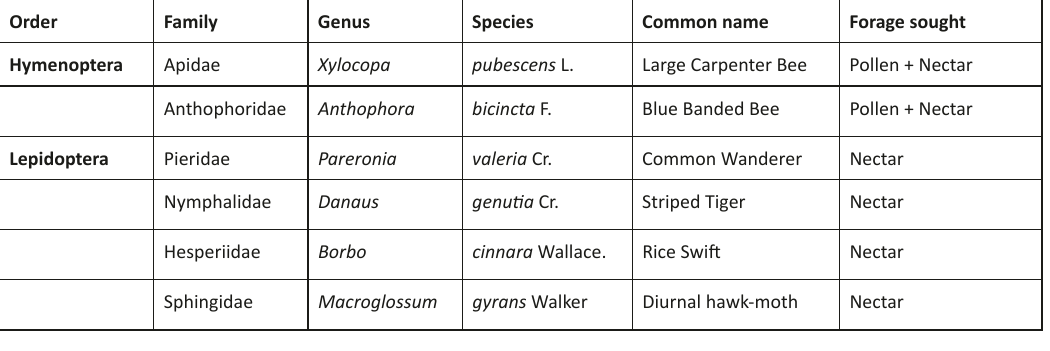
Table 2. List of insect foragers on Clerodendrum inerme